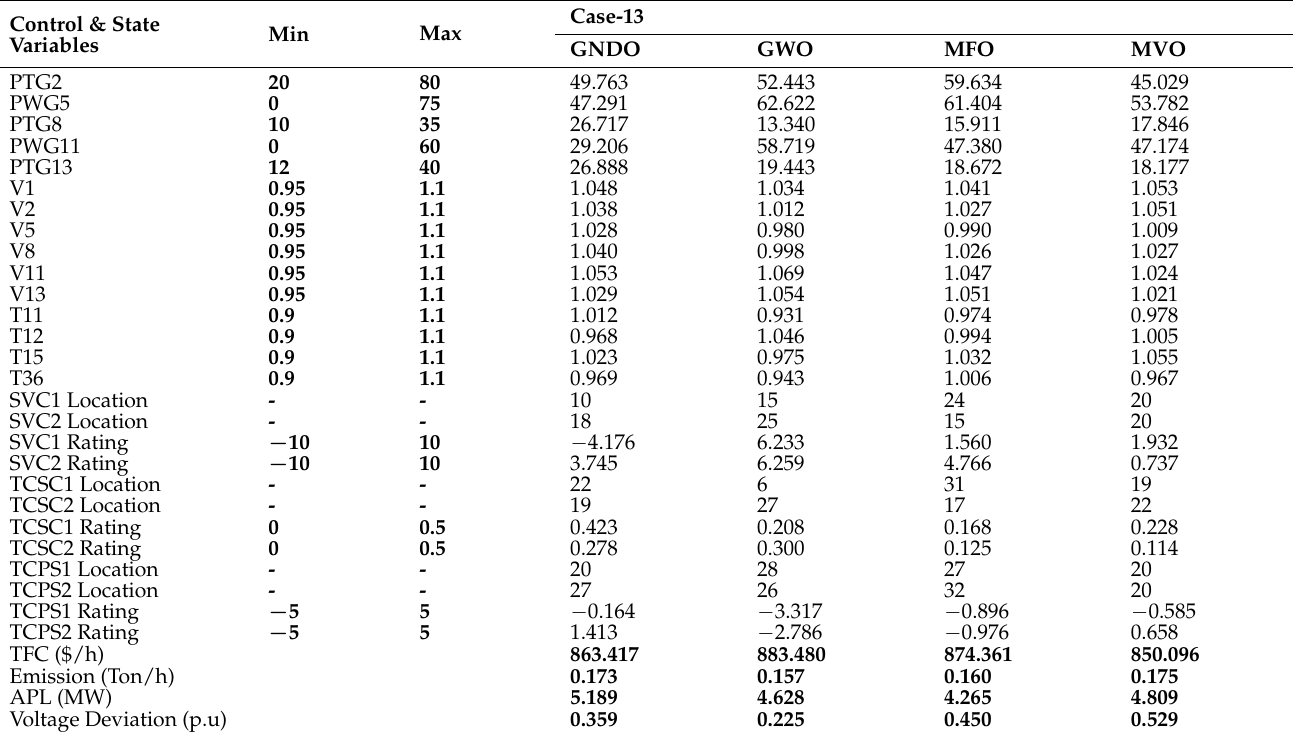
Table 16. Multi-objective simulation results for case